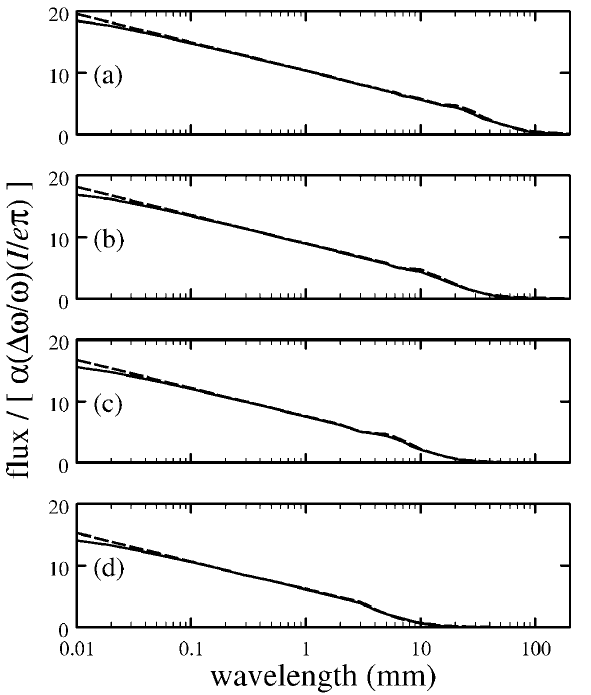
FIG. 3. Extracted flux versus wavelength from a mirror with no hole, for different values of R 0 , the distance from the axis to the extraction window. Solid line: computed flux. Dashed line: flux given by Eq. (18) for a mirror of infinite extent. (a) R 0 (cid:1) 32 mm, (b) R 0 (cid:1) 64 mm, (c) R 0 (cid:1) 128 mm, and (d) R 0 (cid:1) 256 mm.